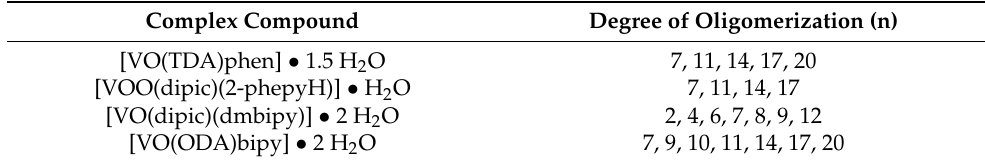
Table 5. Degree of oligomerization for 2-propen-1-ol oligomers obtained using oxovanadium(IV) precatalysts.